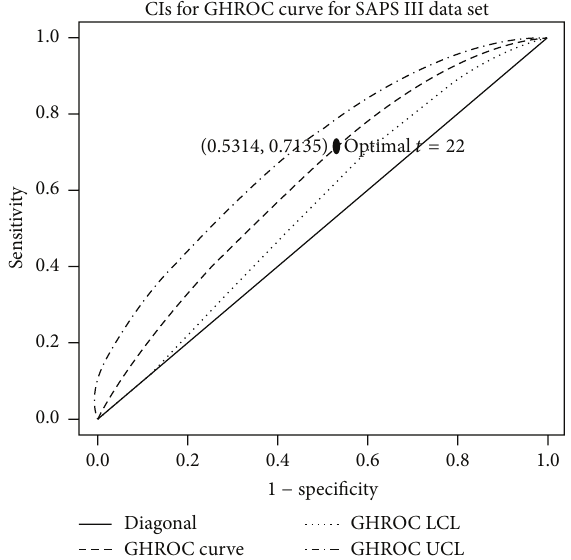
Figure 3: GHROC curve for SAPS III with its confidence